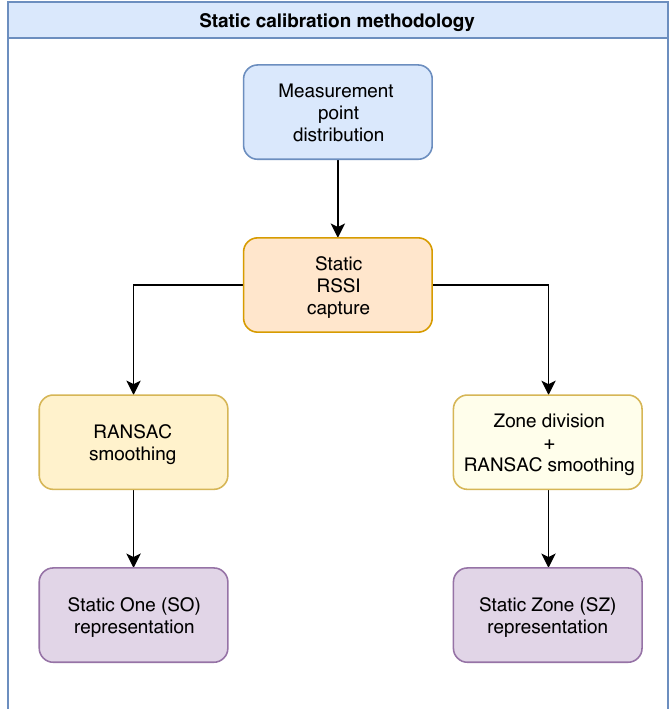
Figure 5. Static calibration methodology procedure. RANdom SAmple Consensus (RANSAC)